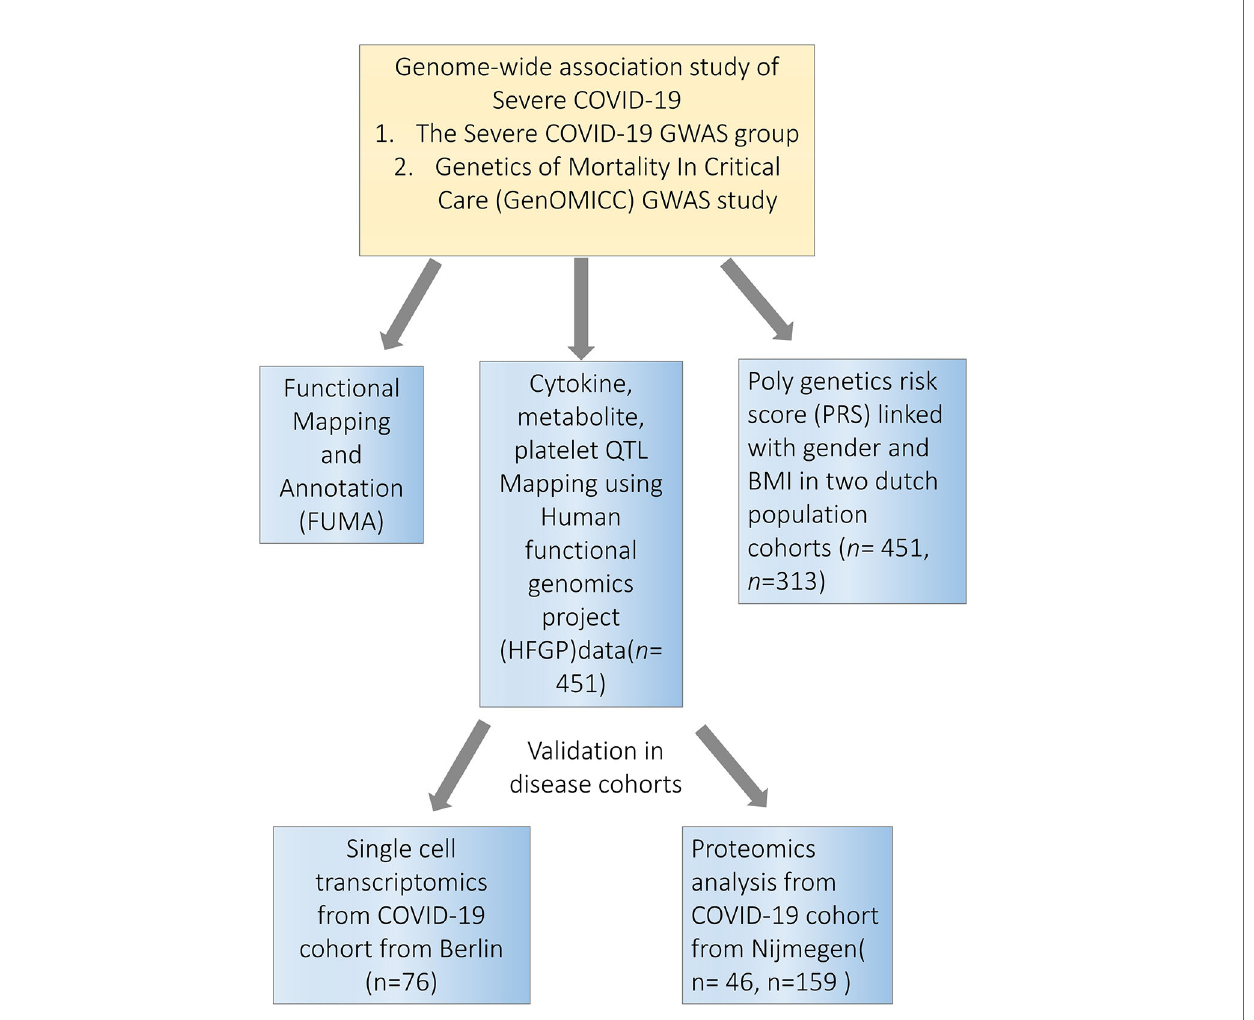
FIGURE 1 | Study overview. Firstly, we performed a functional mapping and annotation (FUMA) to link COVID-19 SNPs to gene expression and identi fi ed important pathways and tissues contributing to the pathophysiology of COVID-19. Secondly, we utilized the cytokine quantitative trait loci (QTL), metabolite QTL and plate QTL from Human Functional Genomics Projects (HFGP) 500FG data (n=451) to test if speci fi c loci are associated with immune functions. Thirdly, we linked PRS score with gender and BMI in 500FG (n=451) and 300BCG (n=313) cohorts. Lastly, we validated our fi ndings in disease cohorts in single-cell transcriptomics data from Berlin (n=76), and proteomics data from Nijmegen (n=46, n=159). SNPs, single-nucleotide